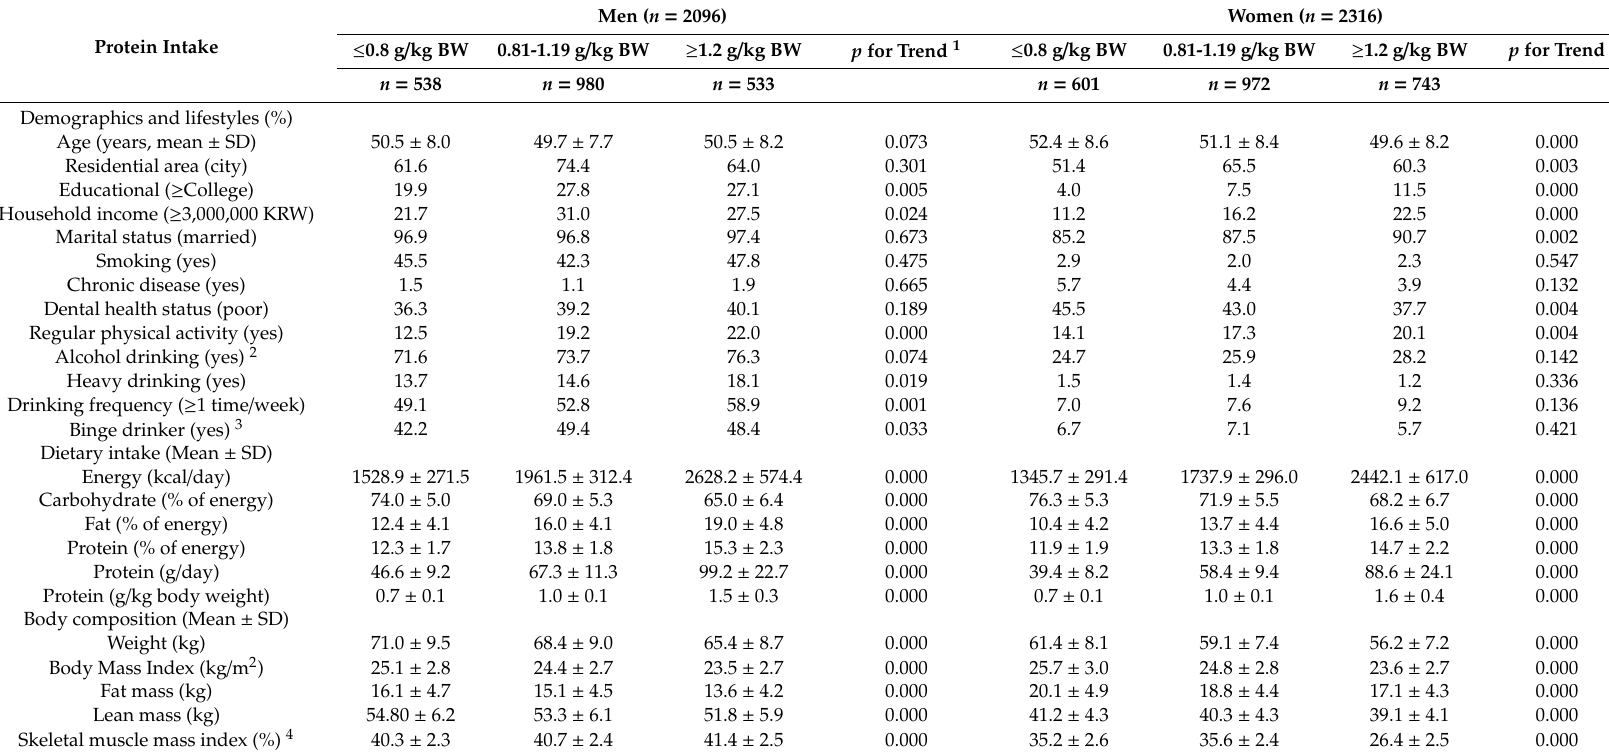
Table 1. General characteristics of study participants by the levels of total protein intake at